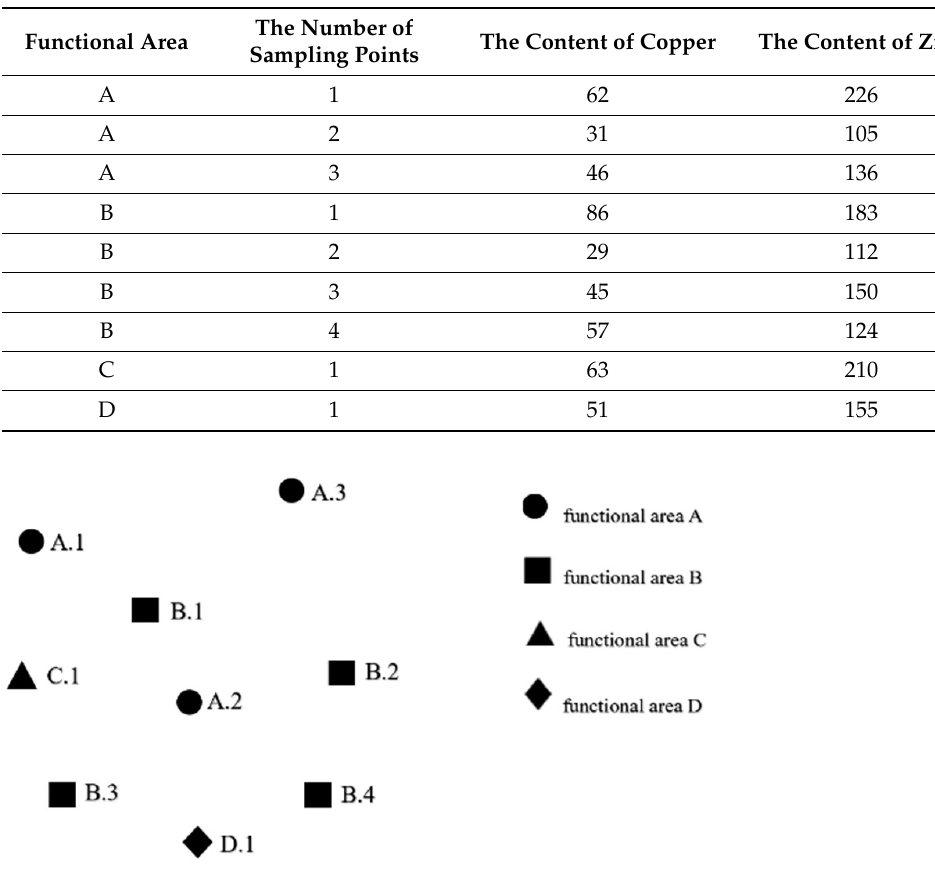
Figure 1. Spatial distribution of sampling Figure 1. spatial distribution of sampling points.